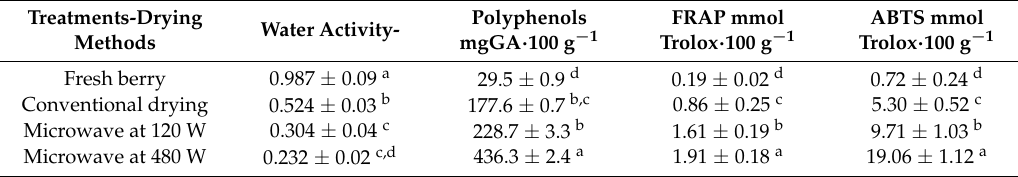
Table 1. Content of water activity, total polyphenols and antioxidant activity in the fruit of Physalis peruviana with different methods of